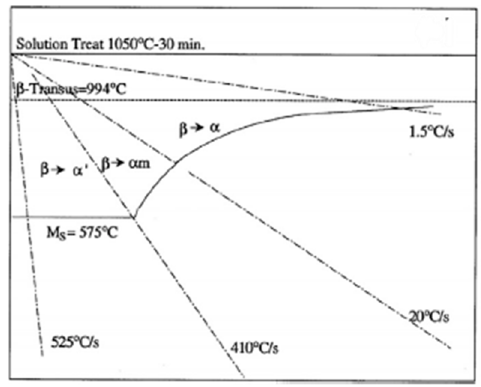
Figure 2. Diagram that explains how the cooling rate affects the phase transformation. Reproduced from [35], under CC BY 4.0.